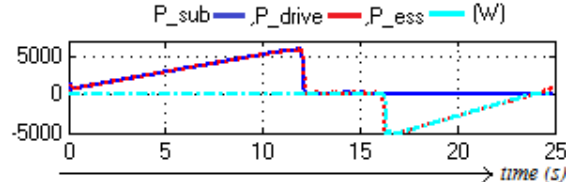
Fig. 9. Simulation diagram of power for both C = 31.5 F and C = 63